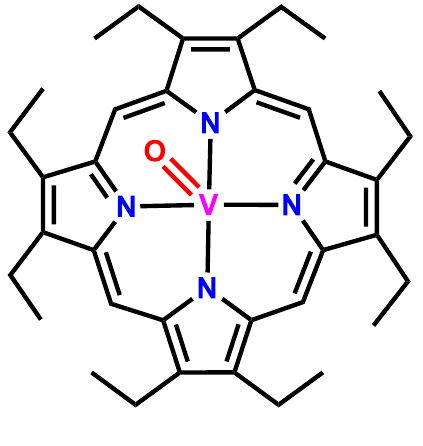
Figure 19. Molecular structure for vanadyl octaethylporphyrin, which elutes to the Resins fraction.